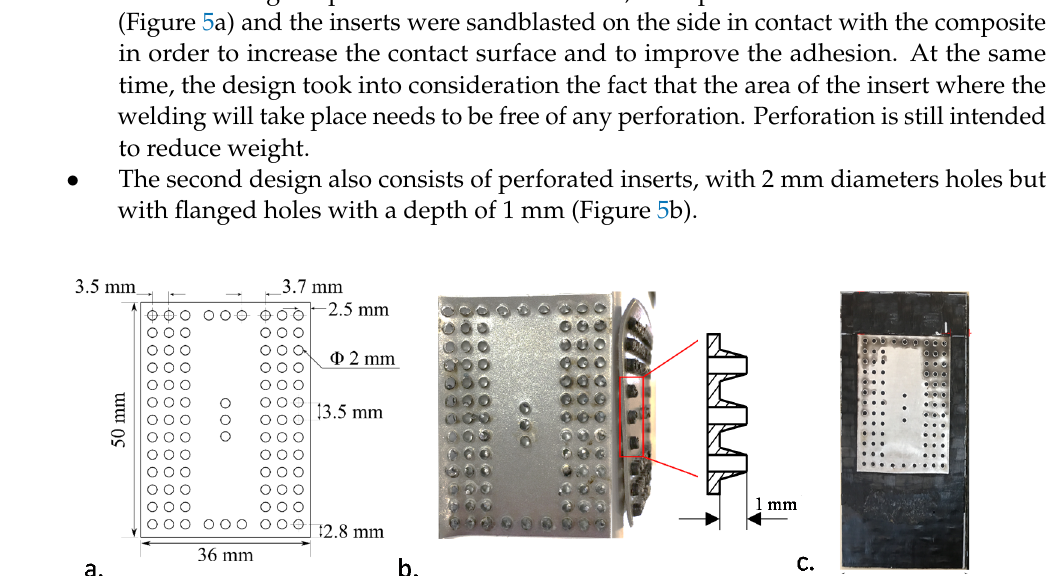
Figure 5. ( a ) Perforated metallic insert (first design); ( b ) Metallic insert with flanged holes (second design); ( c ) FRPC single specimen with metallic insert after over-molding with thermo-compression process.